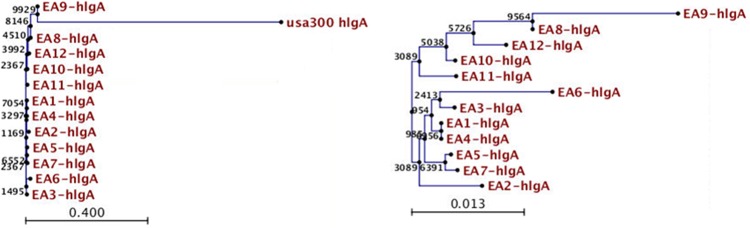
Dendrogram of the differences between study isolates (EA1 through EA12) and the USA 300 reference strain at the gamma hemolysin subunit (HlgA) (left) and dendrogram of the polymorphisms of the gamma hemolysin subunit of the study isolates (right).The tree was generated by neighbor joining analysis with a bootstrap of 10,000. The numbers refer to the confidence of related associations. Higher numbers indicate greater confidence.